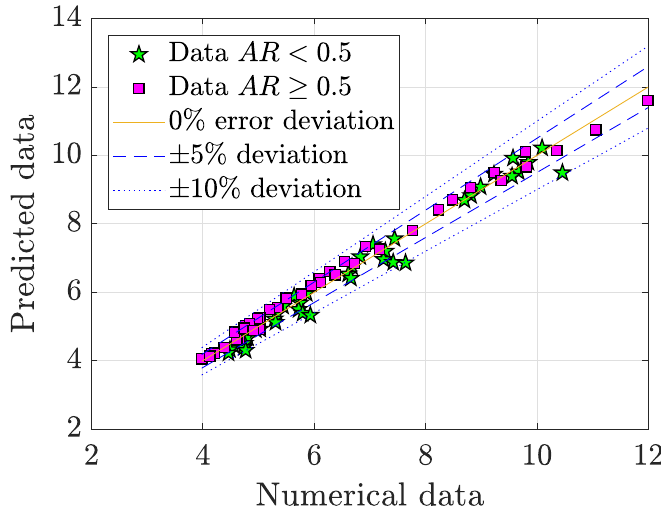
Figure 16. Model fit for (cid:104) Cd (cid:105) as a function of (cid:104) P p (cid:105) )